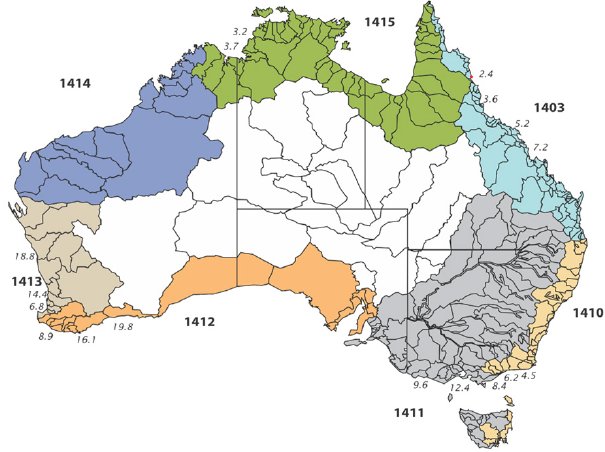
Fig. 13. Australian water catchments grouped by COSCAT zones (filled colours). Bold numbers denote COSCAT zones. Italicised numbers denote representative DOC concentrations [mgL − 1 ] from measurements taken in adjacent catchment rivers. COSCAT zones are based on a combination of coastal shelf morphology, coastal current patterns, and climate gradients (Meybeck, Durr, and Voros- marty, 2006).